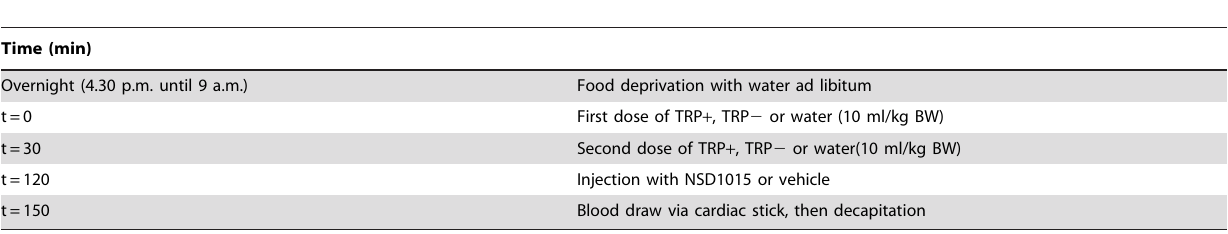
Table 2. Time Course of Biochemistry